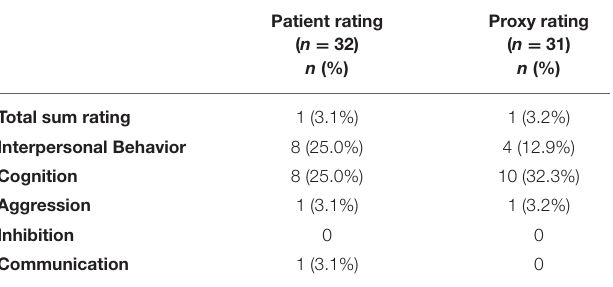
TABLE 4 | Number of patients below cut-off ( T -score below 40) self-rated or rated by